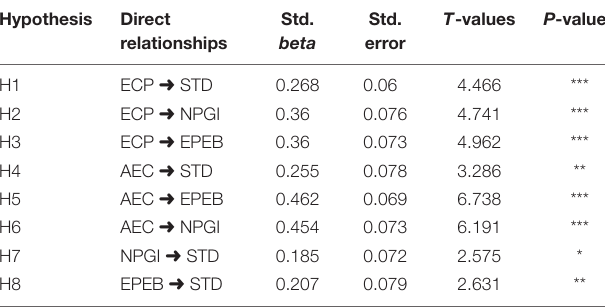
TABLE 5 | Hypotheses testing direct